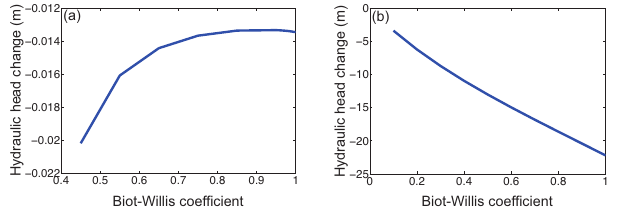
Figure A1. Dependence of central, initial hydraulic head change on the Biot–Willis coefficient. (a) pyroclastic aquifer (b) lava flow aquifer.